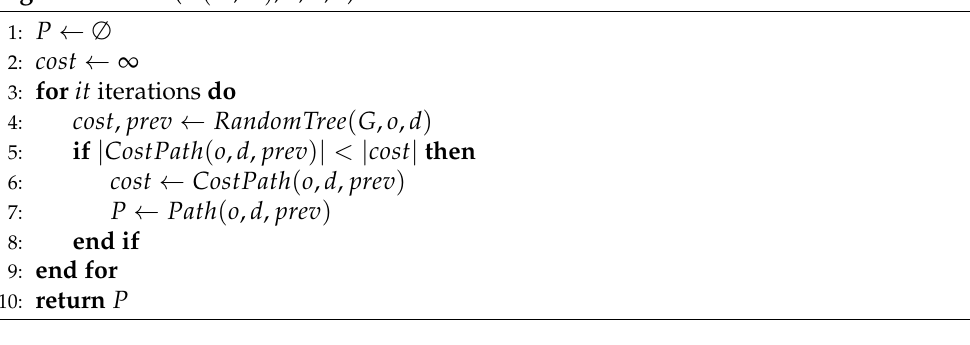
Algorithm 5 RP ( G ( N , A ) , o , d , it ).